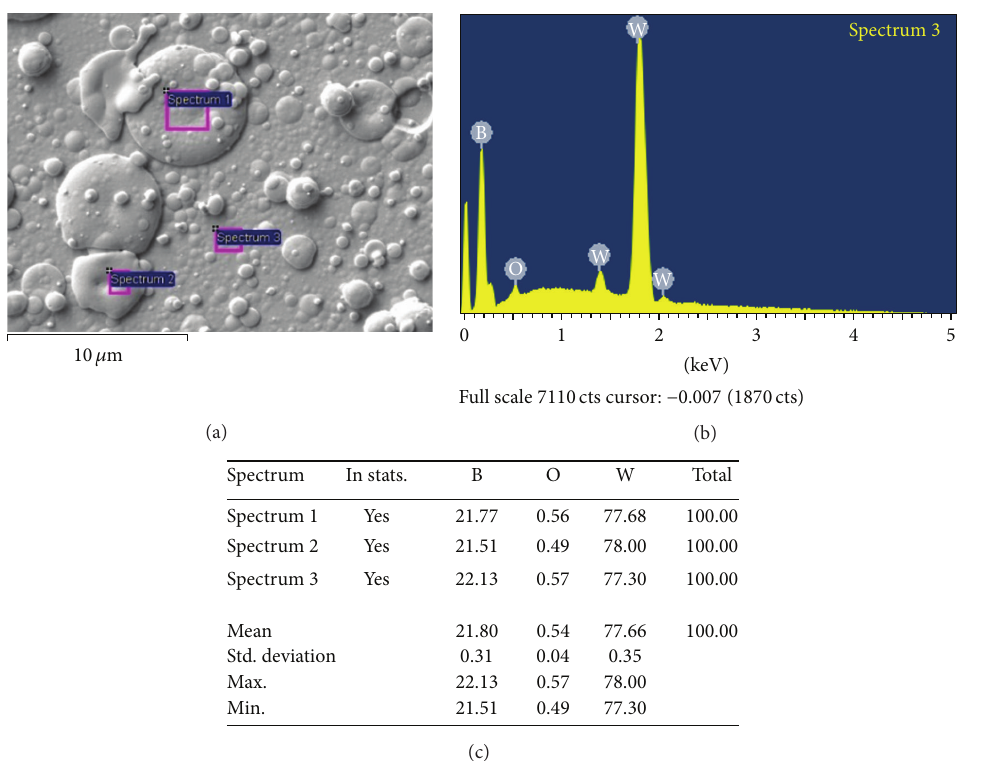
Figure 6: SEM micrograph of deposited WB 3 film (magnification × 5000) with EDS measurement points (a) and the abundances of elements in the deposited film in the spot spectrum 3 (b) and table reporting the composition of the film in examined areas (c).